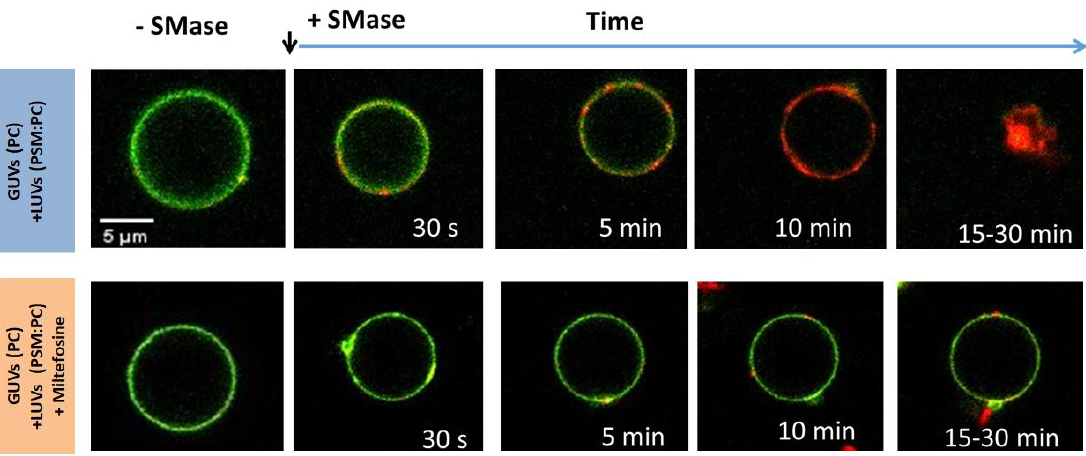
Figure 4. SMase promotes the fusion of GUVs with LUVs membranes and destabilization of the lipid bilayer upon CER accumulation. The presence of Miltefosine inhibits such a process. Confocal microscopy images of GUVs of PC labeled with NBD-PE (green) and fusogenic LUVs PSM:DOPE (80:20) or PSM:PE with 20 mol % of Miltefosine, labeled with Rho-PE (red). Samples were excited at the NBD excitation λ and images show the overlay of NBD and RHO emission channels. The red signal signs FRET occurring after vesicle fusion and lipid mixing. Extracted from [76].